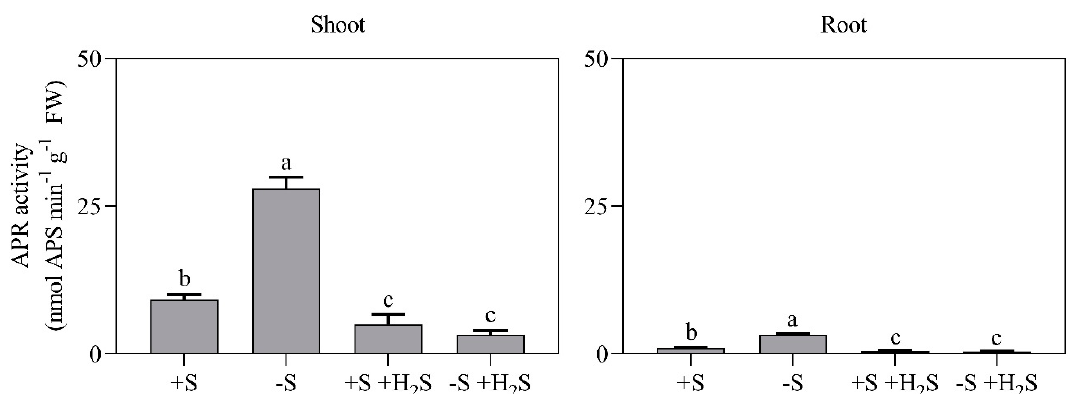
Figure 4. APR activity in barley shoots and roots in the presence and absence of a H 2 S and sulfate supply. For experimental details, see the legend of Figure 1. Data represent the average of 3 measurements with 3 plants per measurement (± SD). Significant differences between treatments are indicated with different letters ( P ≤ 0.05; two ‐ way ANOVA; Tukey’s HSD test as a post ‐ hoc test).